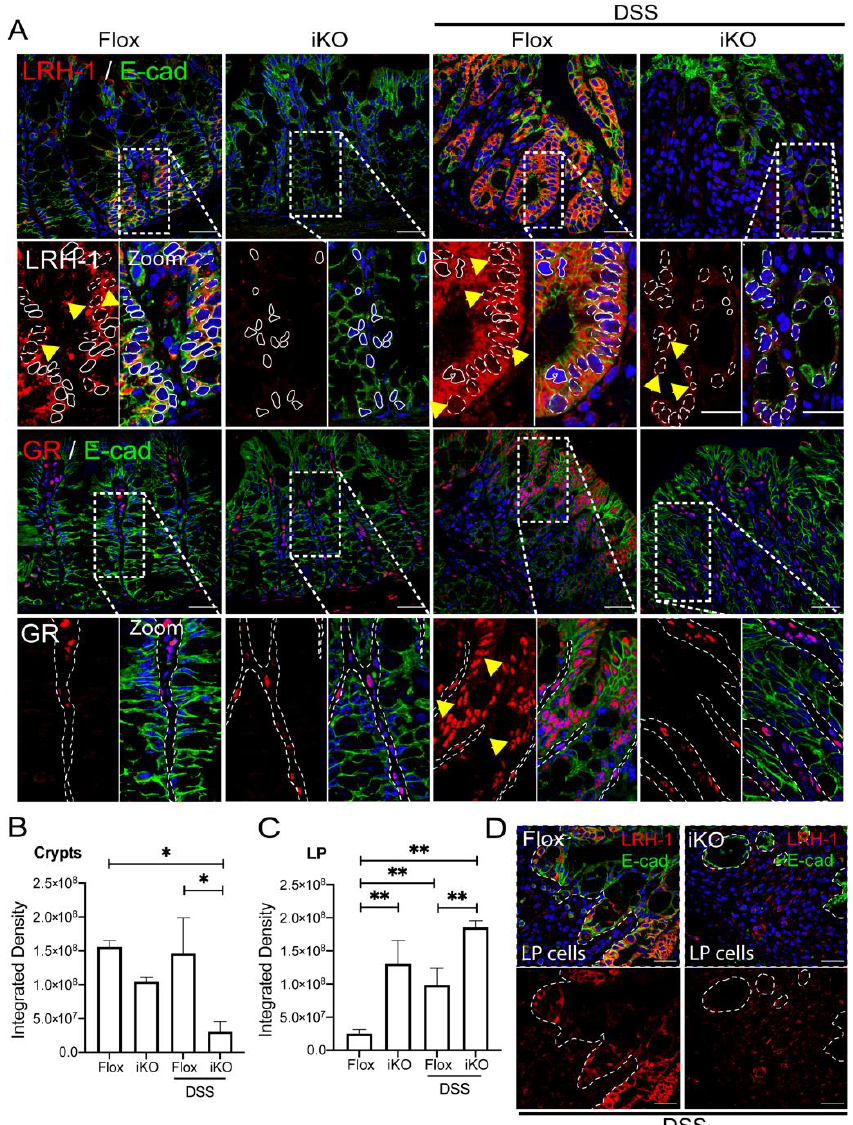
Figure 4. LRH-1 upregulated in intestinal mucosa lamina propria from DSS-treated GR iKO mice. ( A ) Representative images of LRH-1 and total GR (red) immunofluorescent staining with co-localization of E-cadherin (green) as epithelial marker in intestinal mucosa from vehicle and DSS-treated GR flox and GR iKO mice. Hoechst was used for nuclear counterstaining. In the LRH-1 zoomed image: dashed line and/or yellow arrows: positive nuclear stain; solid line: negative nuclear stain. In the GR zoomed image, yellow arrows: positive nuclear stain; dashed line: epithelial outline. Objective 60X. Scale bar 30 μm. (vehicle n = 4 GR flox and 3 GR iKO , DSS-treated n = 4 GR flox and 6 GR iKO ); ( B ) Integrated density from immunofluorescence images calculated from epithelial crypts; and ( C ) LP cells from intestinal mucosa of vehicle and DSS-treated GR flox and GR iKO mice, with ( D ) a representative image showing LRH-1 stain in LP from DSS-treated groups. Dashed line: epithelial outline. * p < 0.05, ** p < 0.01.